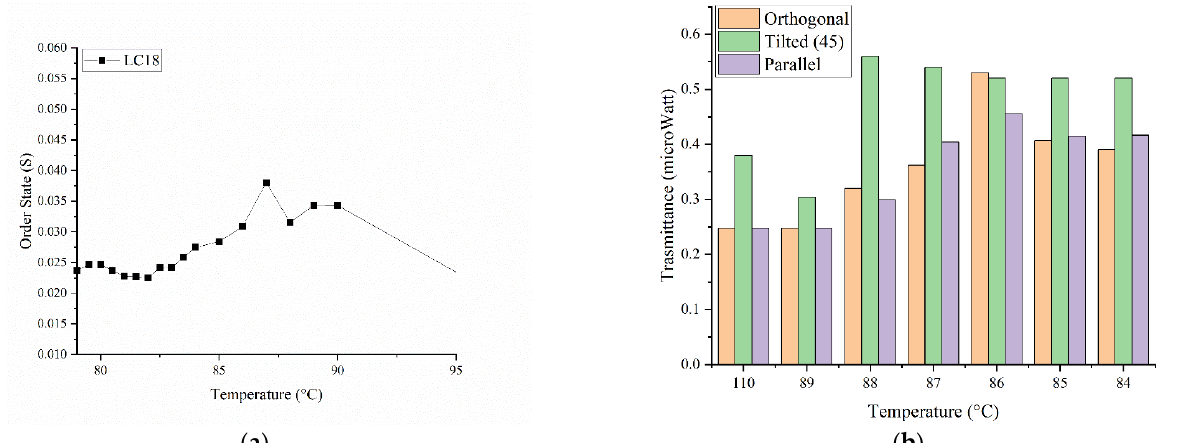
Figure 4. ( a ) Example of order state graph of LC18 and ( b ) transmittance of the cell between two crossed polarizers.